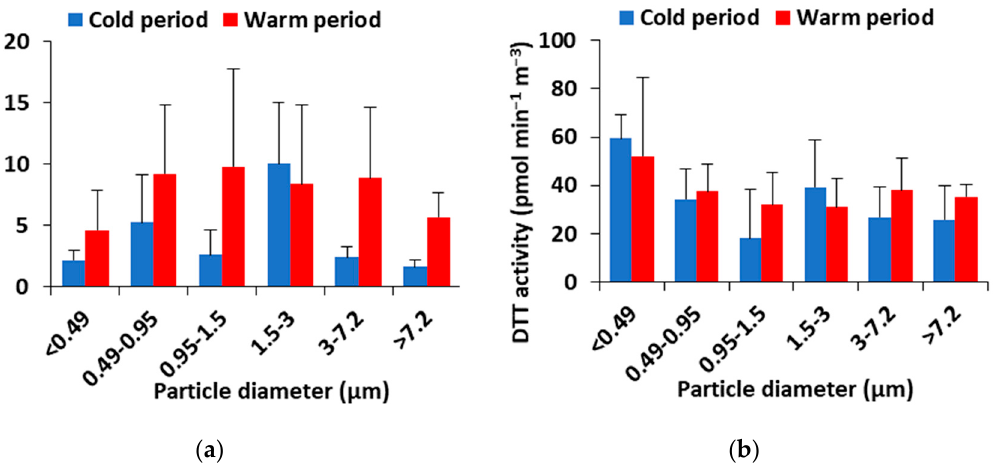
Figure 3. Average concentrations of: ( a ) OPm DTT ; ( b ) OP VDTT in various size fractions during the cold and warm periods (Error bars show min and max).